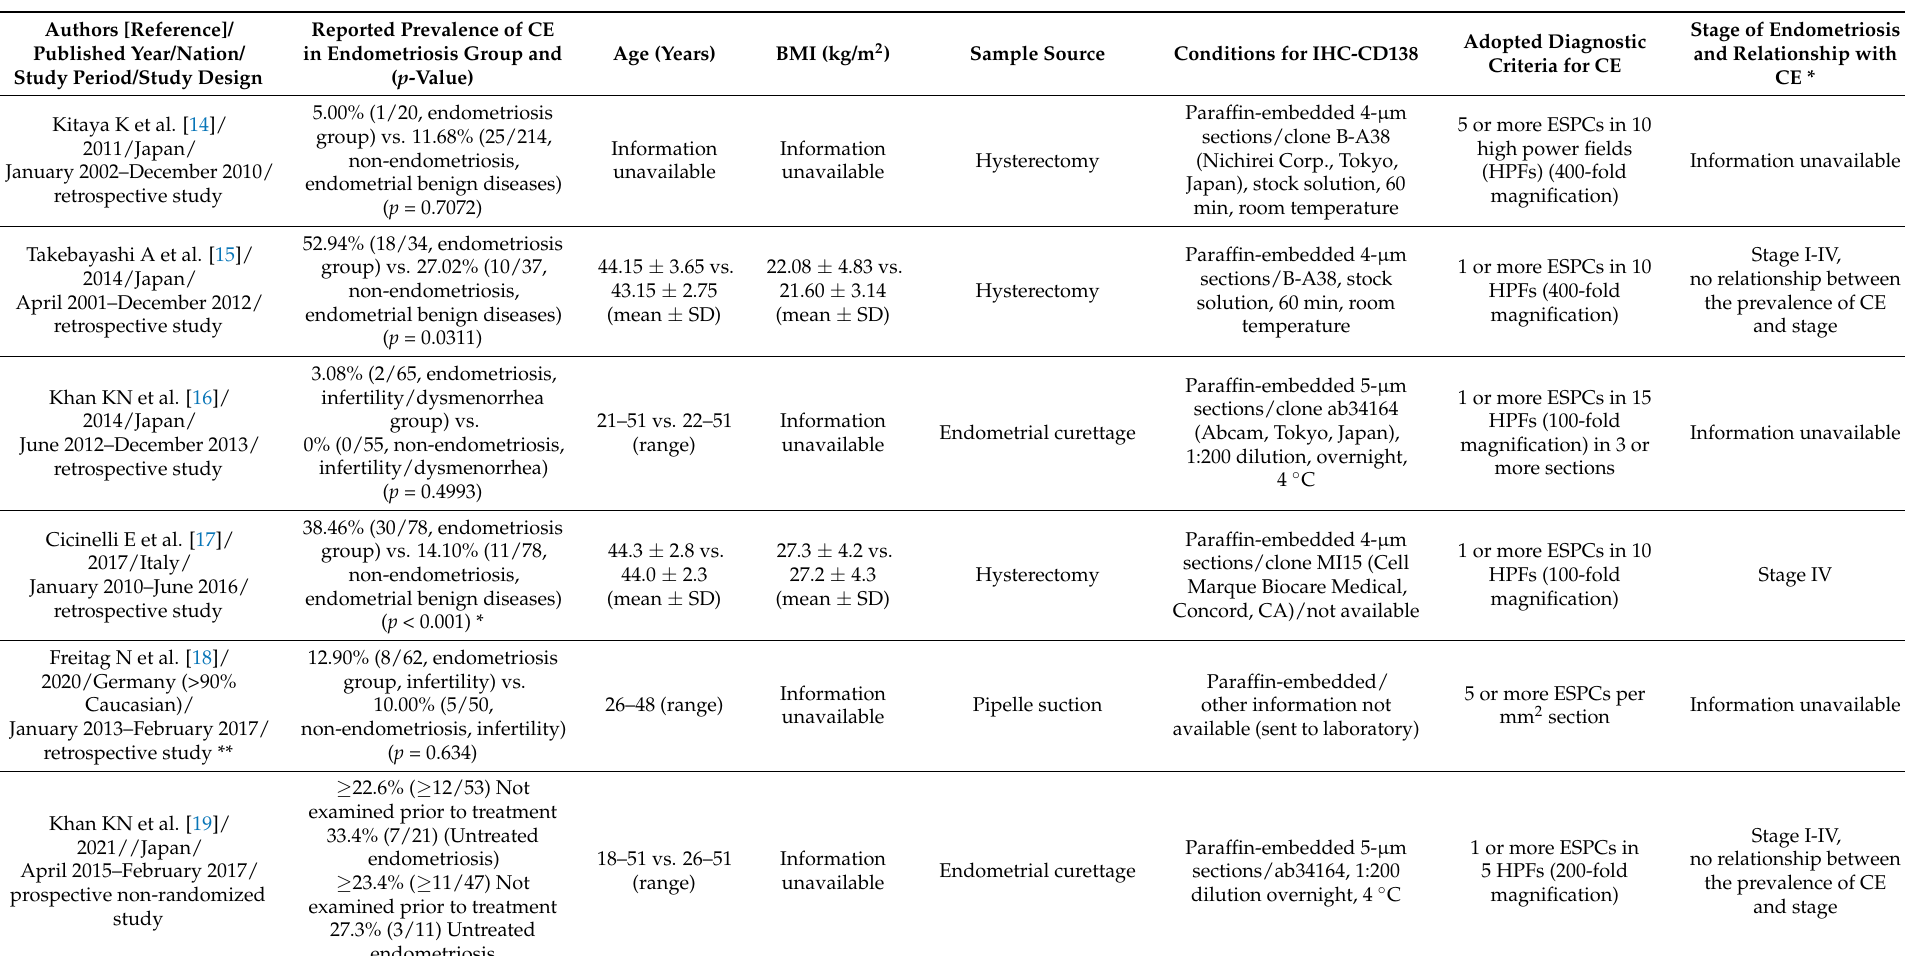
Table 1. Publications on the prevalence of histopathologic CE (diagnosed according to IHC-CD138) in women with or without